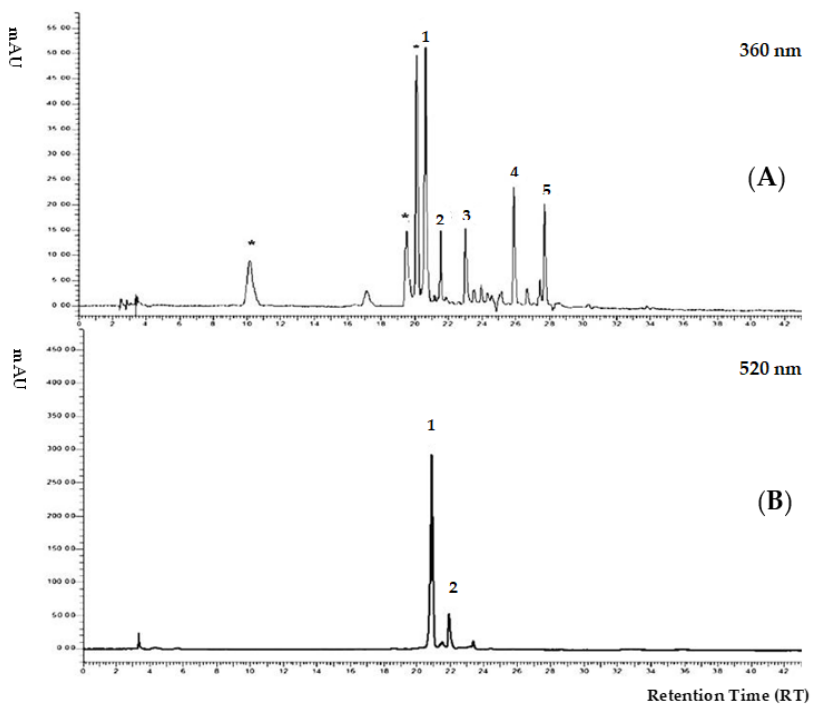
Figure 2. Example chromatograms recorded at 360 nm ( A ) and at 520 nm ( B ). * unknown compounds; 1: CGR; 2: CR; 3: rutin; 4: quercetin-3-galactoside; 5: